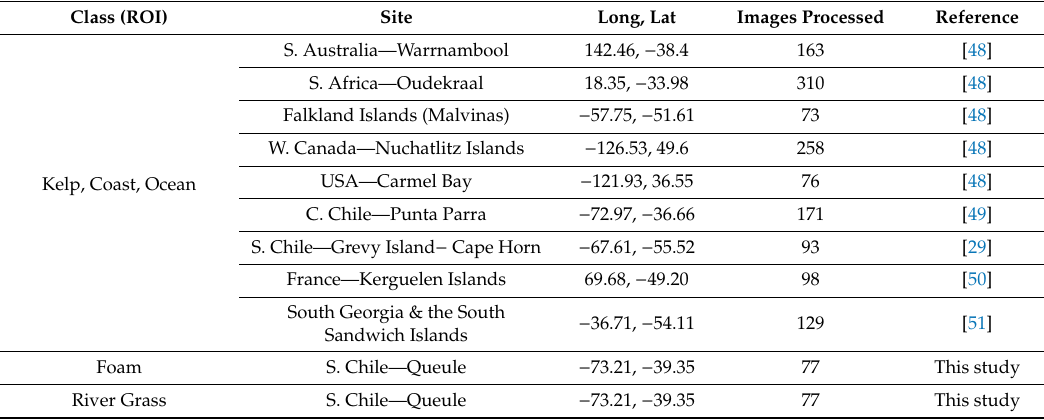
Table 1. Sites selected as training data in this